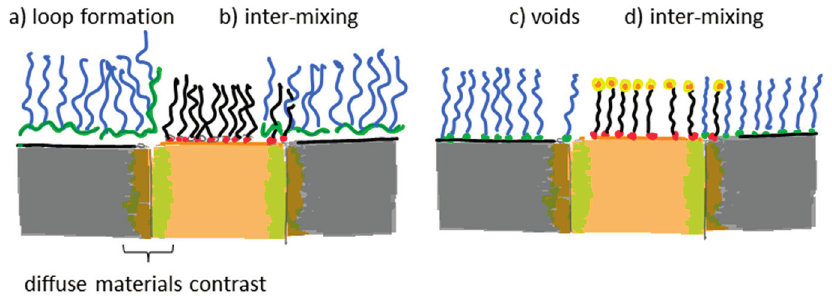
Figure 6. Schematic of materials selective surface functionalization at the interface between two materials. A nanoscale region where the materials contrast is not ideally defined can be created by interdiffusion of the materials or by an additional bridging material (e.g., adhesion layer). The surface functionalization is then likely affected in any of several ways: for multivalent weak anchors ( a ) loop formation producing charged or hydrophobic defects can occur; ( b ) intermixing and a diffuse biochemical contrast can be created; for chemisorbing single anchors; ( c ) voids due to insufficient binding can open the substrate to nonspecific binding (can also occur for multivalent weak anchors); ( d ) intermixing and a diffuse biochemical contrast can be